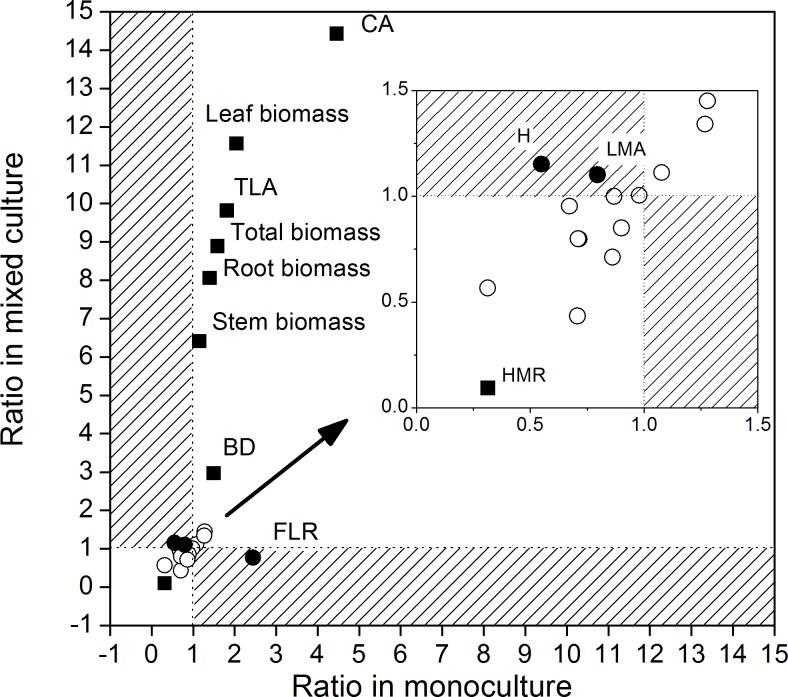
A schematic representation of the functional traits ratio between Rhus typhina and Vitex negundo var. heterophylla in monoculture and mixed culture treatments.The crowded points were enlarged on the top right corner. LMA Specific leaf weight, BD Basal diameter, H Plant height, CA Crown area, TLA Individual total leaf areas, FLR Fallen leaf ratio, HMR The ratio of plant height to aboveground biomass. The areas with diagonal stripes refer to the “reversal region”, where the trait values have an opposite trend in monoculture and mixed culture treatments. Traits located in the “reversal region” are indicated by filled circle points; traits that have the same trends but show two-fold or greater differences in monoculture and mixed culture treatments are indicated by filled square points.